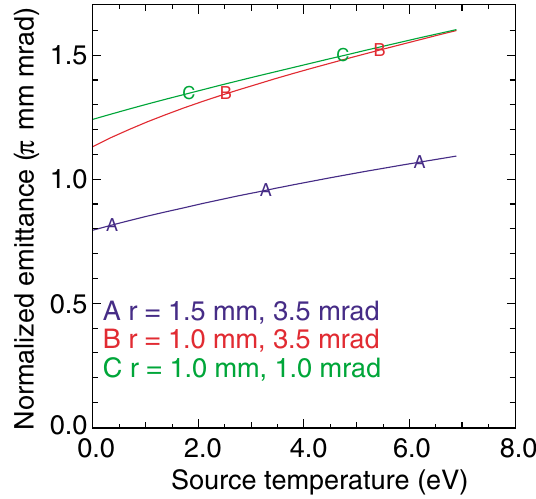
FIG. 8. (Color) Variation of final emittance with a range of initial source temperatures.